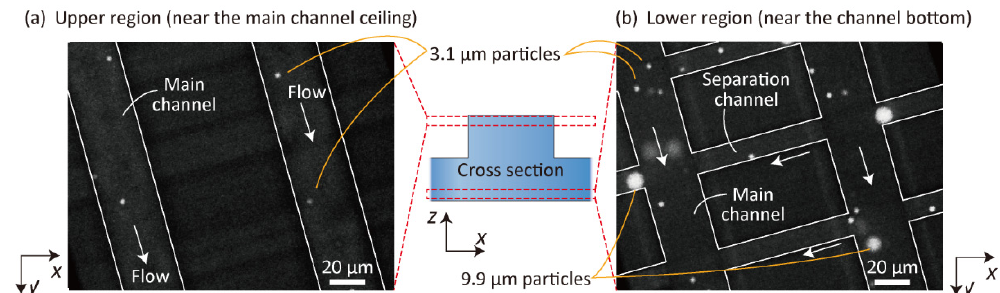
Figure 5. High-speed confocal microscopic images showing the flow behaviors of 3.1- and 9.9- µ m particles ( a ) in the upper region (near the main-channel ceiling) and ( b ) in the lower region (near the channel bottom). Small circular dots indicate 3.1- µ m particles, whereas the large circular objects indicate 9.9- µ m particles. The microchannel is visualized by the white lines.